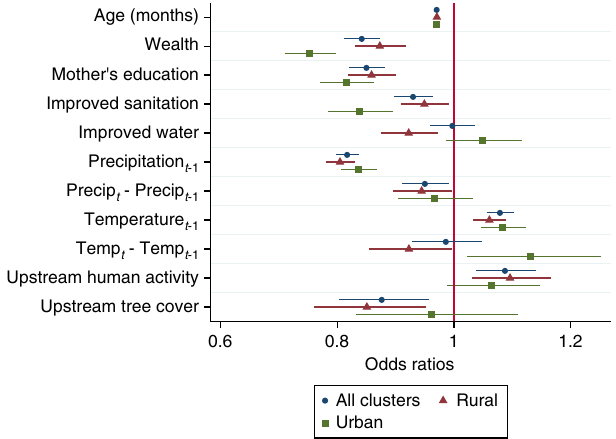
Fig. 2 Factors associated with the probability childhood diarrheal disease. Variables reducing the probability of diarrheal disease (DD) have odds ratios lower than 1 to the left of the red vertical line. Odds ratios and 95% con fi dence intervals (horizontal lines) show statistically signi fi cant associations between socioeconomic variables and the probability of DD in urban and rural households. The bottom two variables indicate that the associations between upstream watershed variables (human activity and tree cover) and the probability of DD are signi fi cant (con fi dence intervals do not cross the red vertical line) for rural, but not urban households. See Supplementary Table 1 for model coef fi